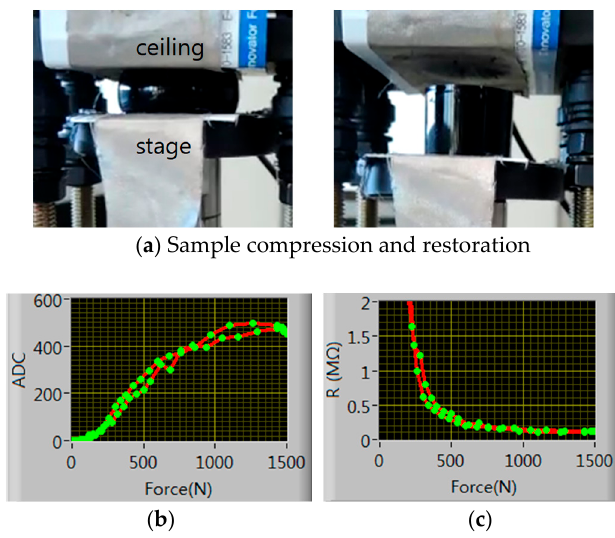
Figure 6. ( a ) Force sensitivity measurement setup, ( b ) force ‐ analog to digital converter (ADC) hysteresis curve, ( c ) force ‐ resistance hysteresis curve(c).